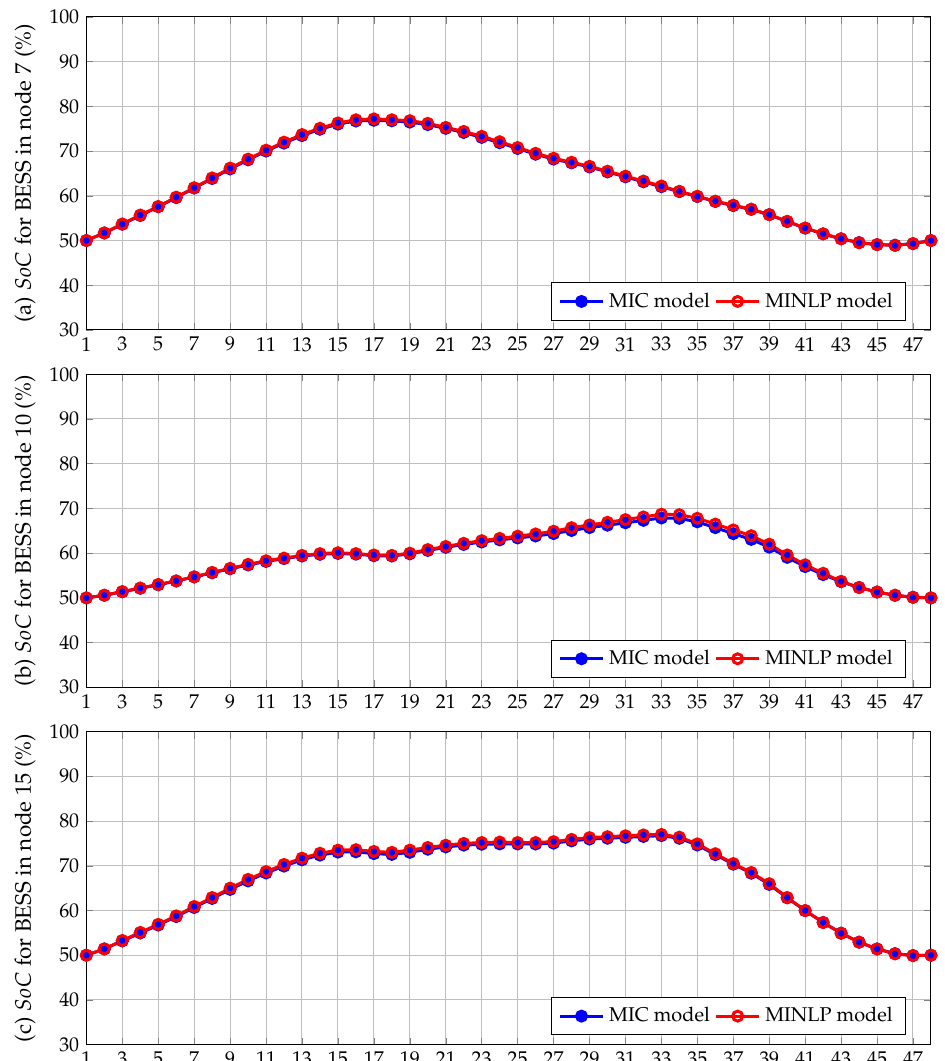
Figure 2. Comparison between exact the MINLP model and the proposed MIC model for Case 1: ( a ) SoC for battery at node 7, ( b ) SoC for battery at node 10, and ( c ) SoC for battery at node 15.